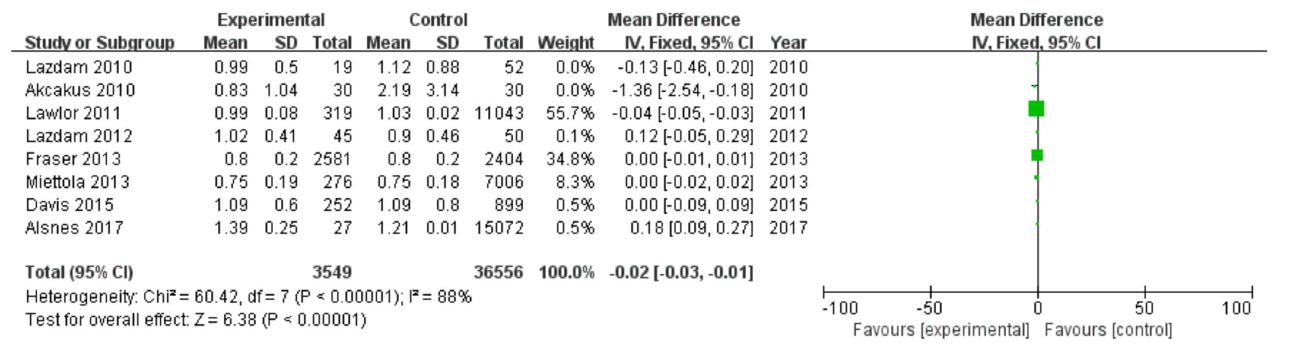
Figure 8. Meta ‐ analysis forest map for triglycerides of offspring of PE pregnancies. Lazdam 2010 [15];